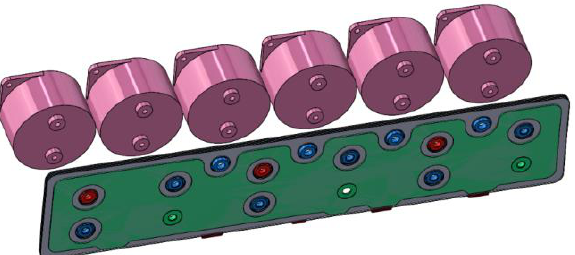
Figure 12. The capacitance distribution of laminated busbar.